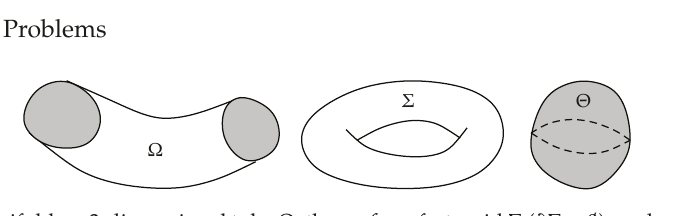
Figure 3: Three manifolds: a 3-dimensional tube Ω , the surface of a toroid Σ (cid:6) ∂ Σ (cid:11) ∅ (cid:7) , and a solid Θ (cid:6) ∂ Θ (cid:11) Γ(cid:7) , where Γ consists of the shaded regions. Reduction is able to reduce cells from cell complex C (cid:6)Ω , Γ Ω (cid:7) , but not from complexes C (cid:6)Σ(cid:7) and C (cid:6)Θ , Γ Θ (cid:7)